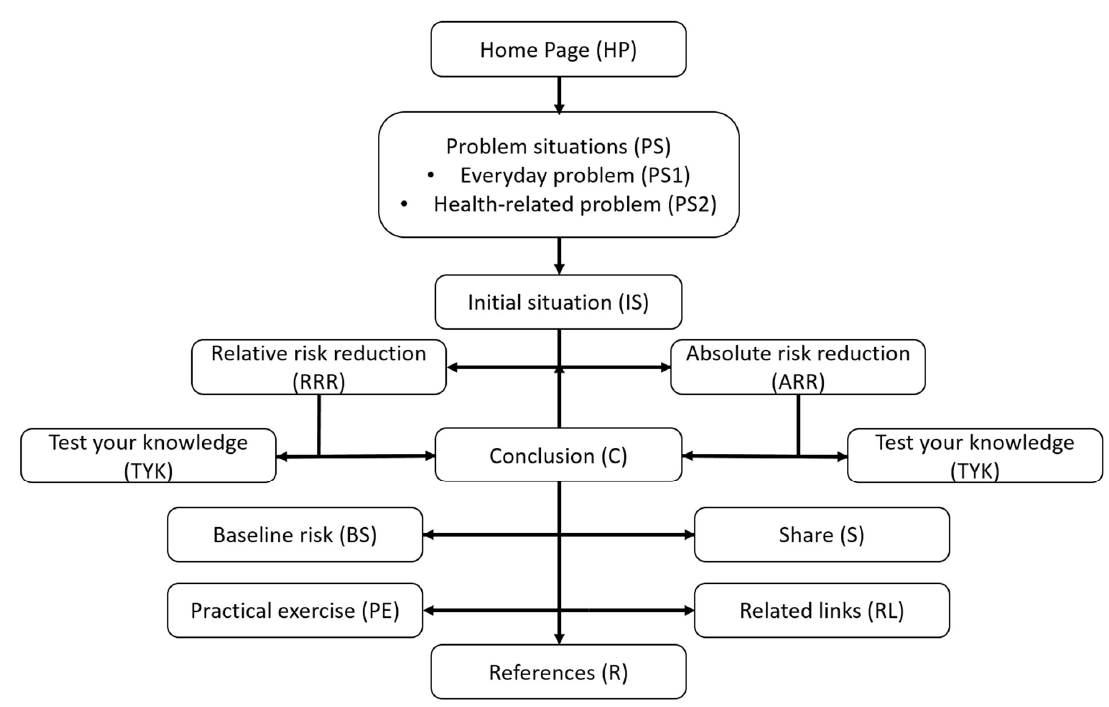
Figure 2. Sequence of topics of the first version of the tool.